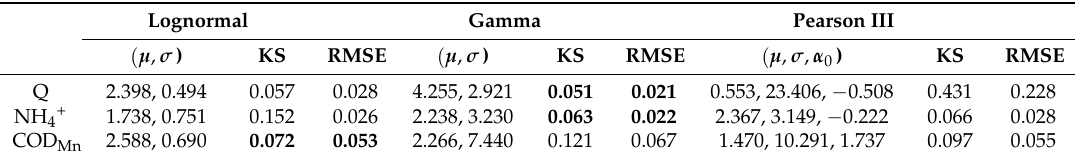
Table 2. The parameters of marginal distributions of Q, NH 4+ , and COD Mn and results of